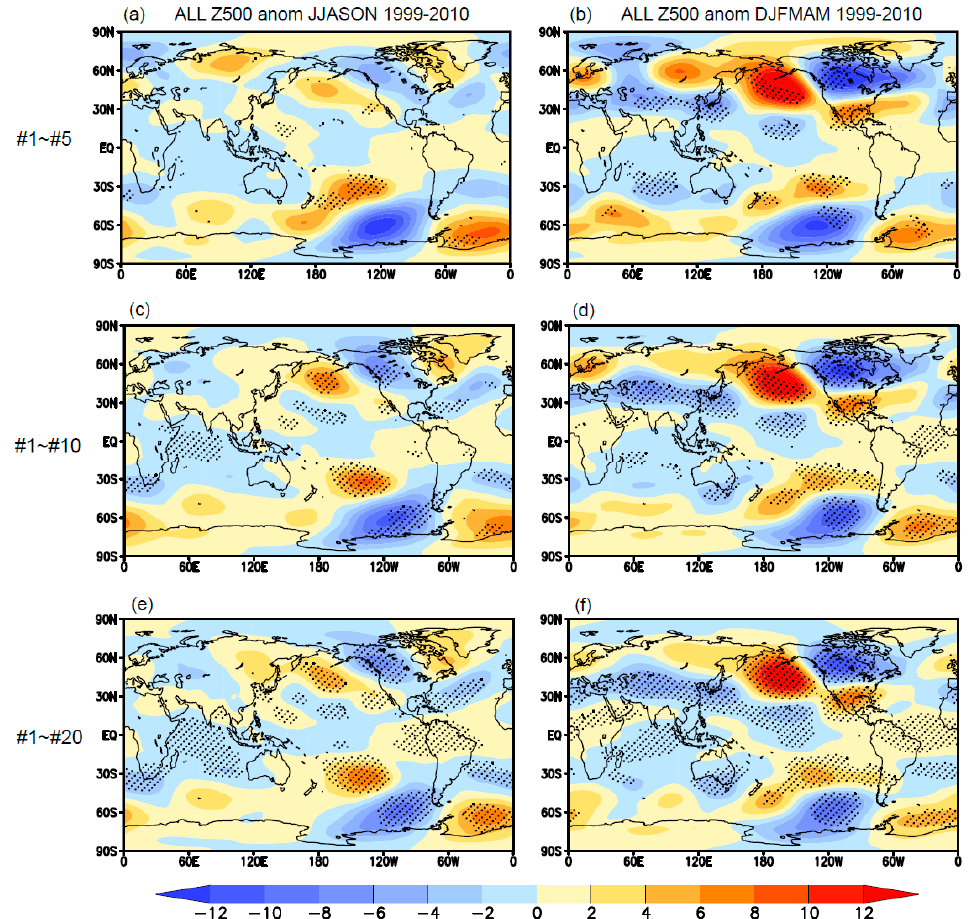
Figure 4. Z500 anomalies of the ALL run (m, zonal mean is removed) averaged from 1999 to 2010 for JJASON (left) and DJFMAM (right). Ensemble average is calculated for randomly-chosen 5 members ( a , b ), 10 members ( c , d ), and 20 members ( e , f ). Dotted areas show values exceeding the 99% confidence level.